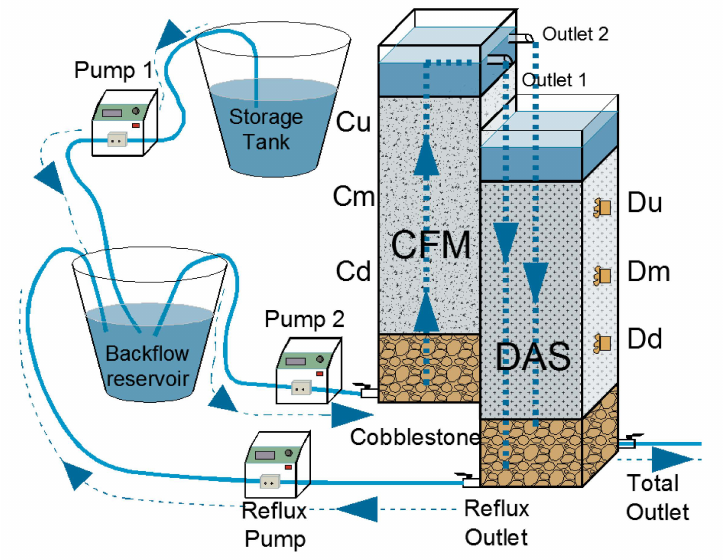
Figure 1. Schematic diagram of ceramic filter medium-dewatered aluminum sludge (CFM-DAS) experimental apparatus and